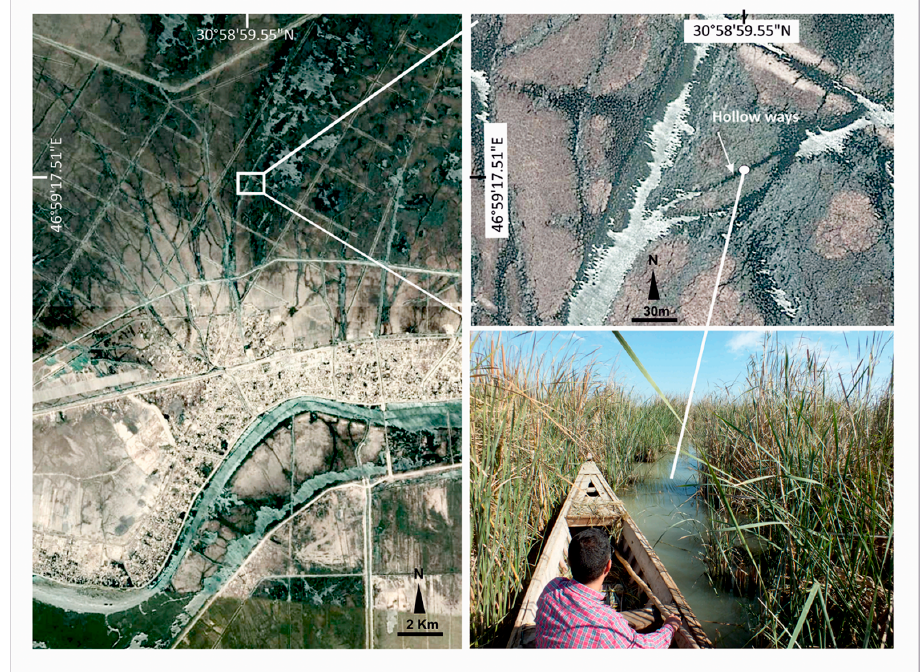
Figure 2. The movement of boats and the herding of water buffalo cause the formation of ‘water passages’ through the dense reeds of marshlands in southern Iraq [24,25,39].